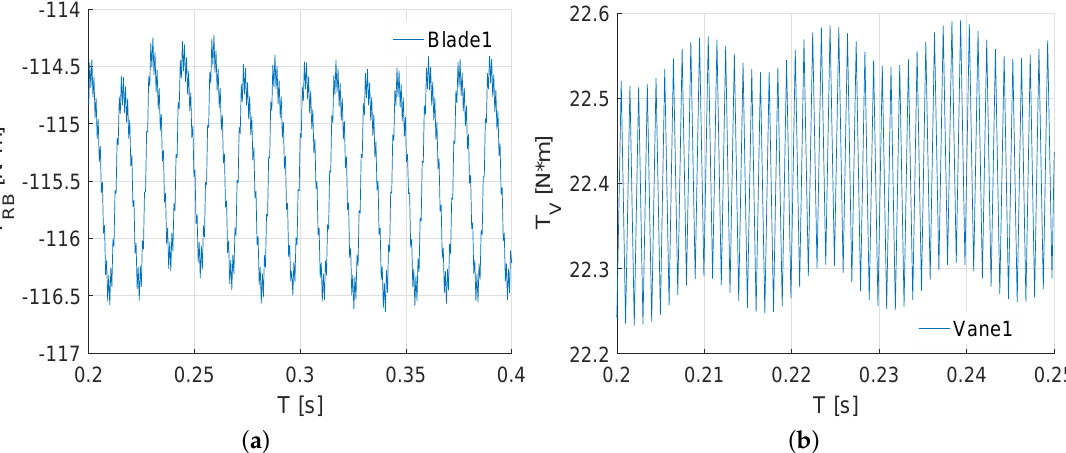
Figure 18. ( a ) Variation of the torque value of the blade in the period of T = 0.20–0.40 s; ( b ) Variation of the torque value of the guide vane in the period of T = 0.20–0.25